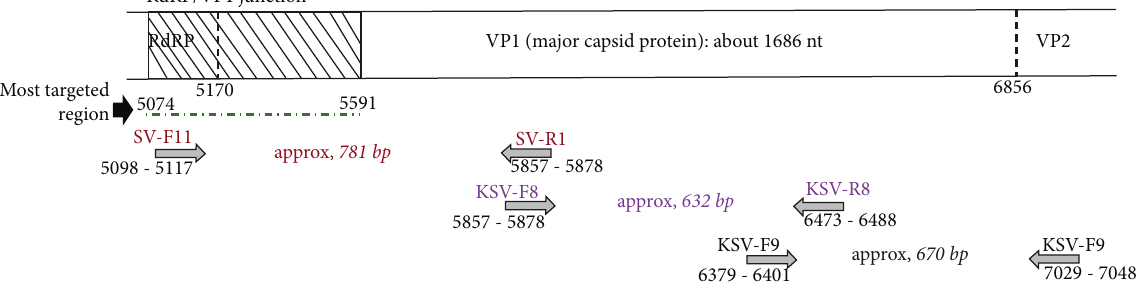
Figure 1: Schematic diagram of human sapovirus partial genomic organization and RT-PCR target regions. The diagram presents the most targeted RdRp/VP1 junction by RT-PCR pointed by a black arrow, and the location of primers targeting the complete VP1 segment shown by grey arrows on the binding location. Table 2: Positive samples by partial VP1